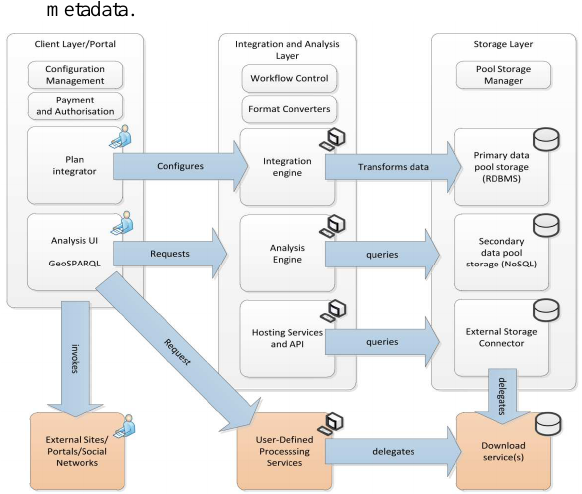
Figure 2: The components of the Plan4business platform (Fraunhofer